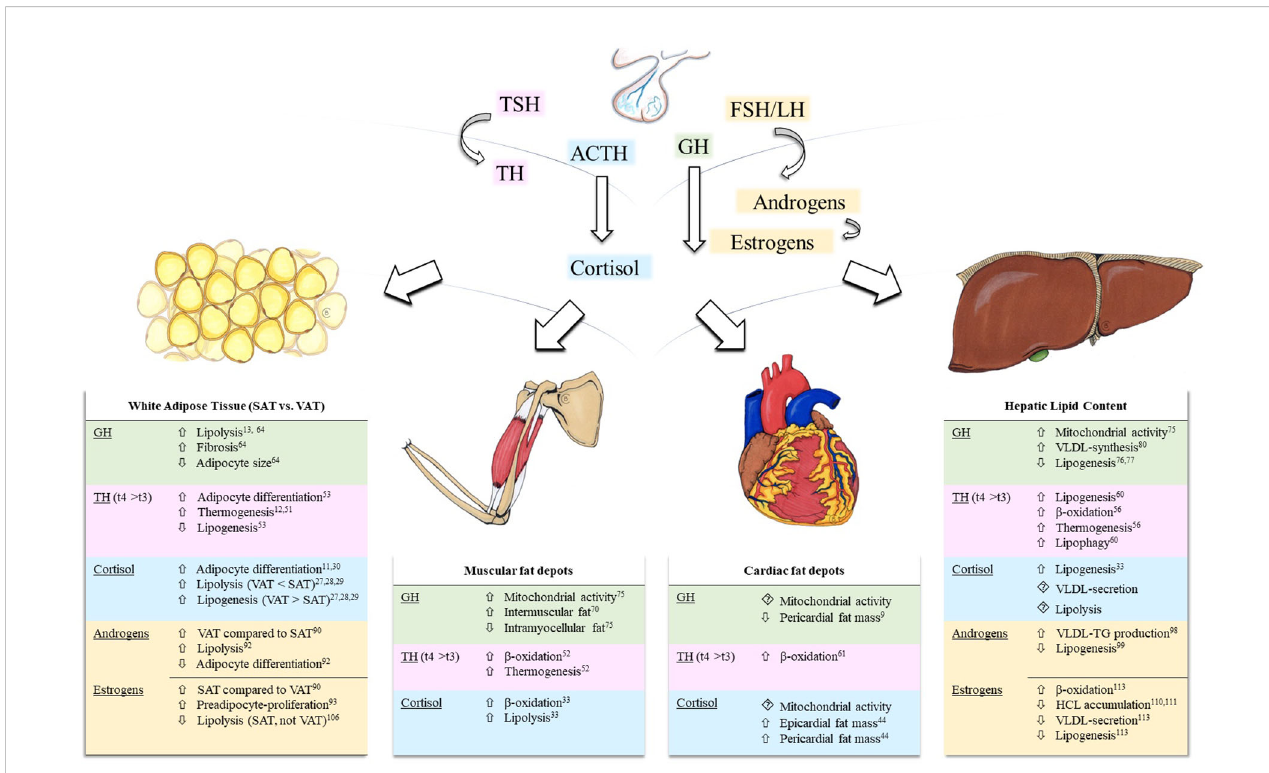
FIGURE 1 Effects of pituitary hormone axes on white adipose tissue and ectopic lipid content. Depicted pituitary axes include the thyroid-axis ( light pink ), growth hormone-axis ( green ), hypothalamic-pituitary-adrenal axis ( blue ), and the hypothalamic-pituitary-gonadal axis ( yellow ). Modulations of ectopic lipid content are summarized in tables for each effector (GH, TH, Cortisol, Androgens, and Estrogens) in skeletal muscle, liver, and heart. Reference numbers are attached as superscript. Background colors correspond to the depicted hormonal axes. Hypothalamic hormones, negative feedback loops, and, due to scarcity of data, prolactin are not shown. ACTH, adrenocorticotropic hormone; FSH, follicle-stimulating hormone; GH, growth hormone; HCL, hepatic lipid content; LH, luteinizing hormone; SAT, subcutaneous adipose tissue; TG, triglycerides; TH, thyroid hormones; TSH, thyroid-stimulating hormone; t4, thyroxine, t3, triiodothyronine; VAT, visceral adipose tissue; VLDL, very-low density